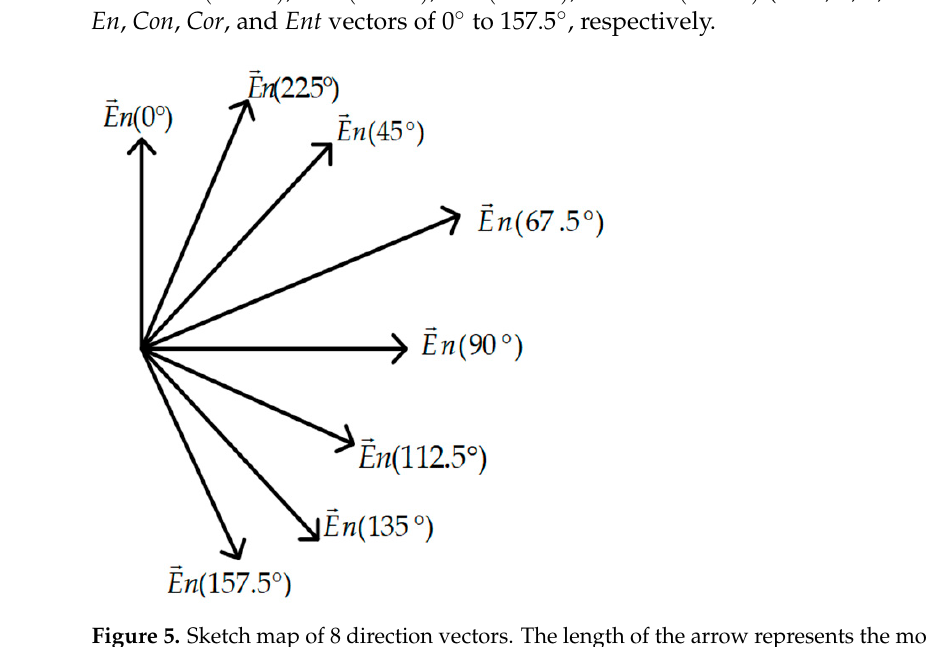
Table 2. Input feature name and dimension of